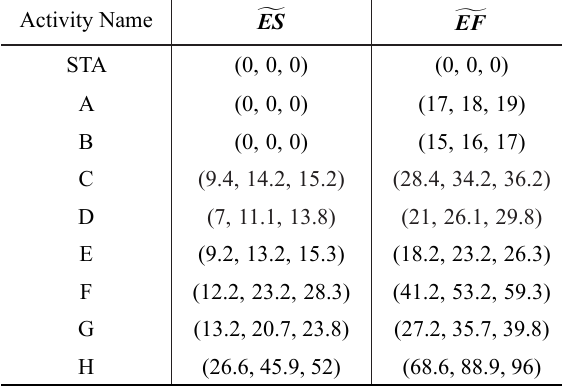
Table 4. Time variable calculations with overlaps